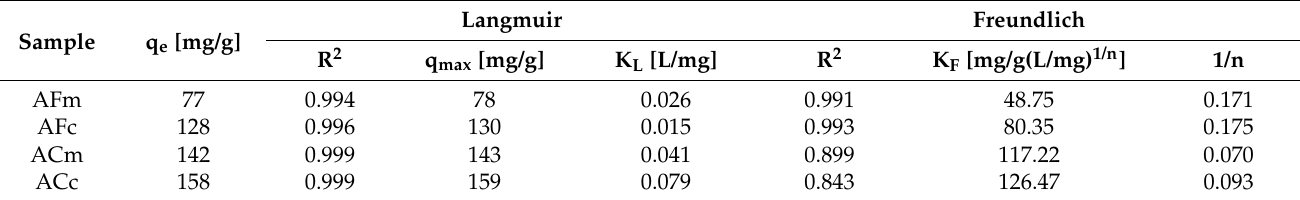
Table 4. Langmuir and Freundlich parameters of the adsorption isotherms of methyl red sodium salt onto